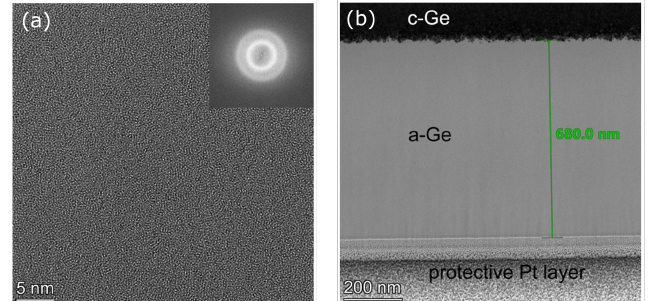
Figure 4. ( a ) HRTEM image and its fast Fourier transform (FFT) showing a completely amorphized Ge layer. ( b ) Image obtained by XTEM method showing a completely amorphized germanium layer of 680 nm thickness on